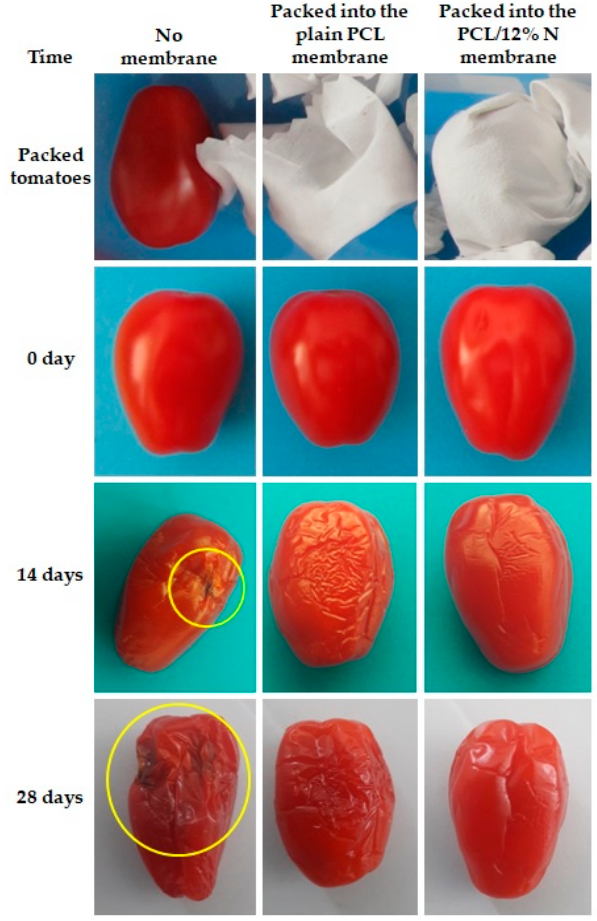
Figure 8. Observational experiments over time with tomatoes for suitability of fibers-based food packaging. The yellow circle highlights the rot.